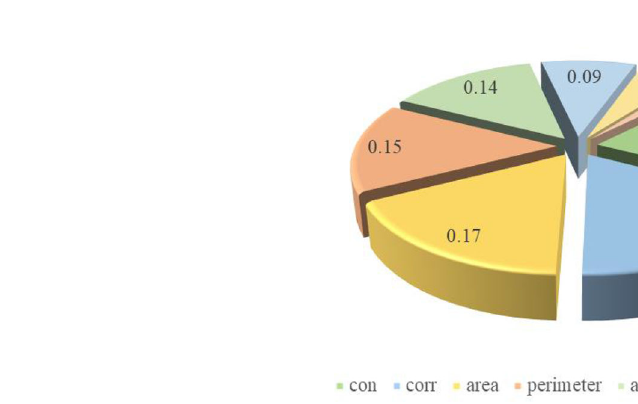
FIGURE 6 The weighted value of each input